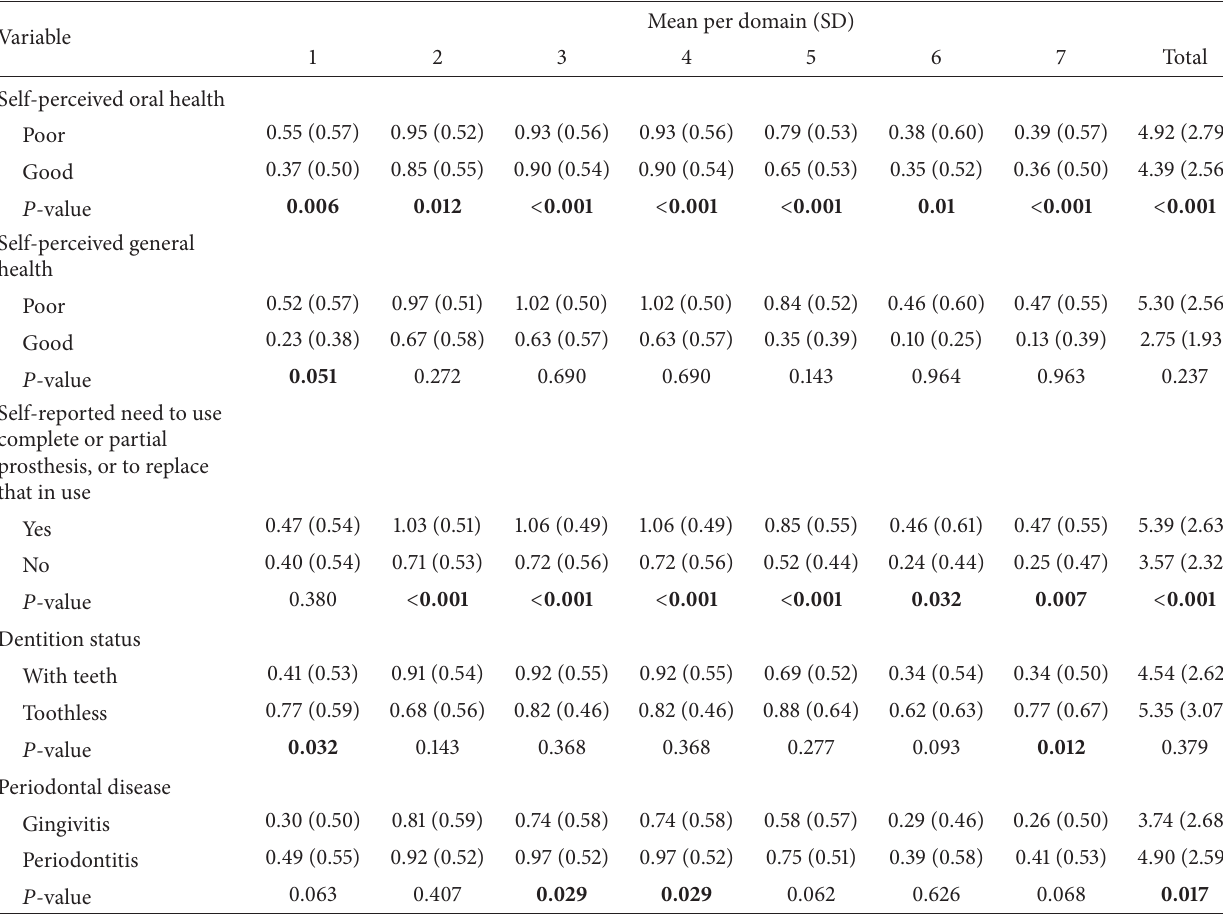
Table 3: Mean and 𝑃 -value (Mann-Whitney) of oral morbidity and self-perception of health per domain and overall OHIP-14 of patients treated in the Periodontics section, Dental Specialty Centres (Centros de Especialidades Odontol´ogicas), Juiz de Fora, 2013.